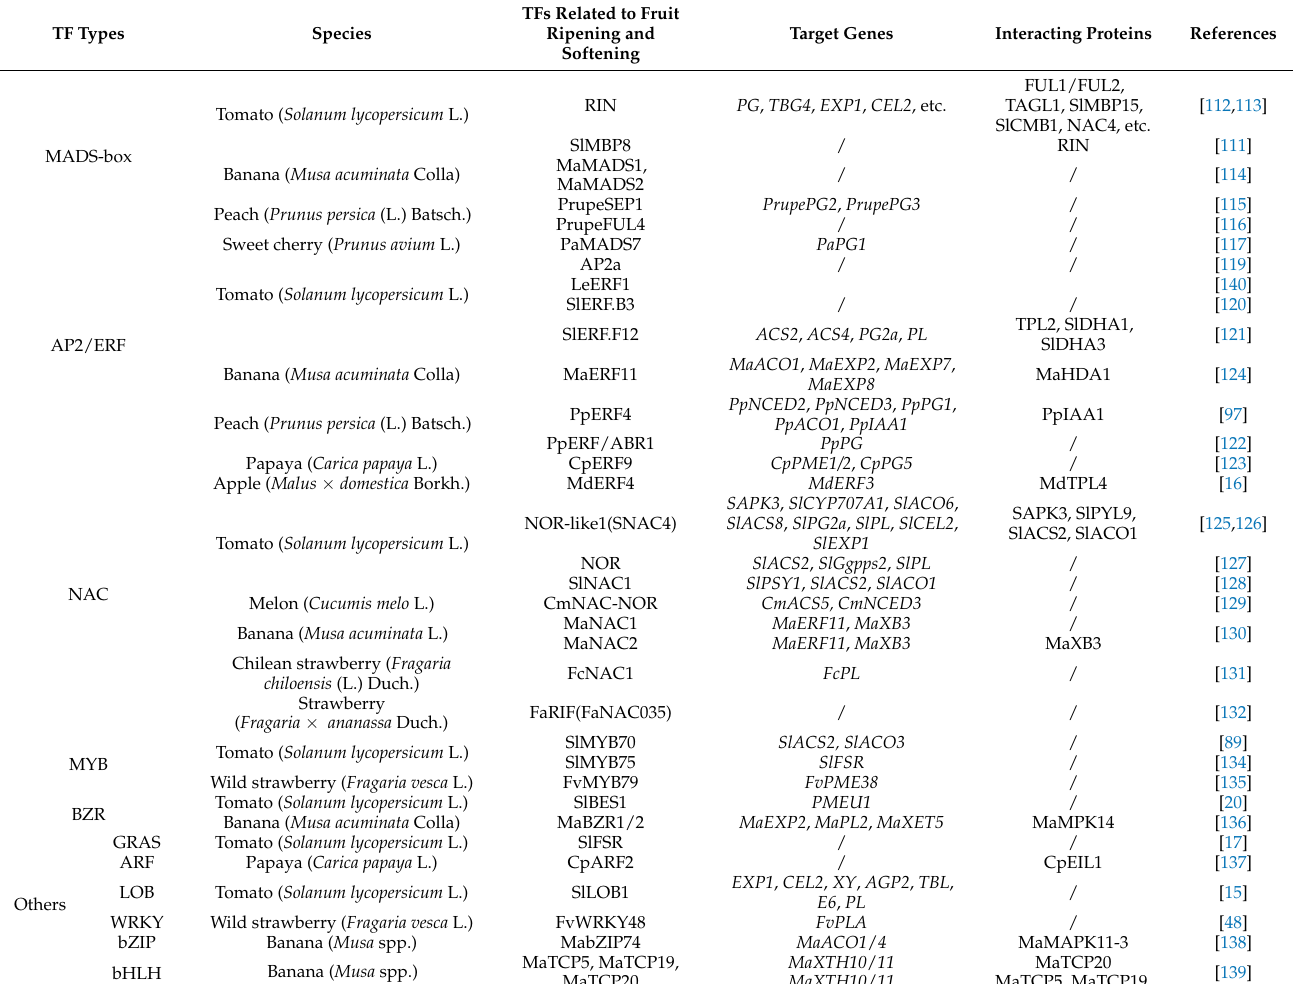
Table 2. TFs involved in the regulation of ripening and softening in fleshy